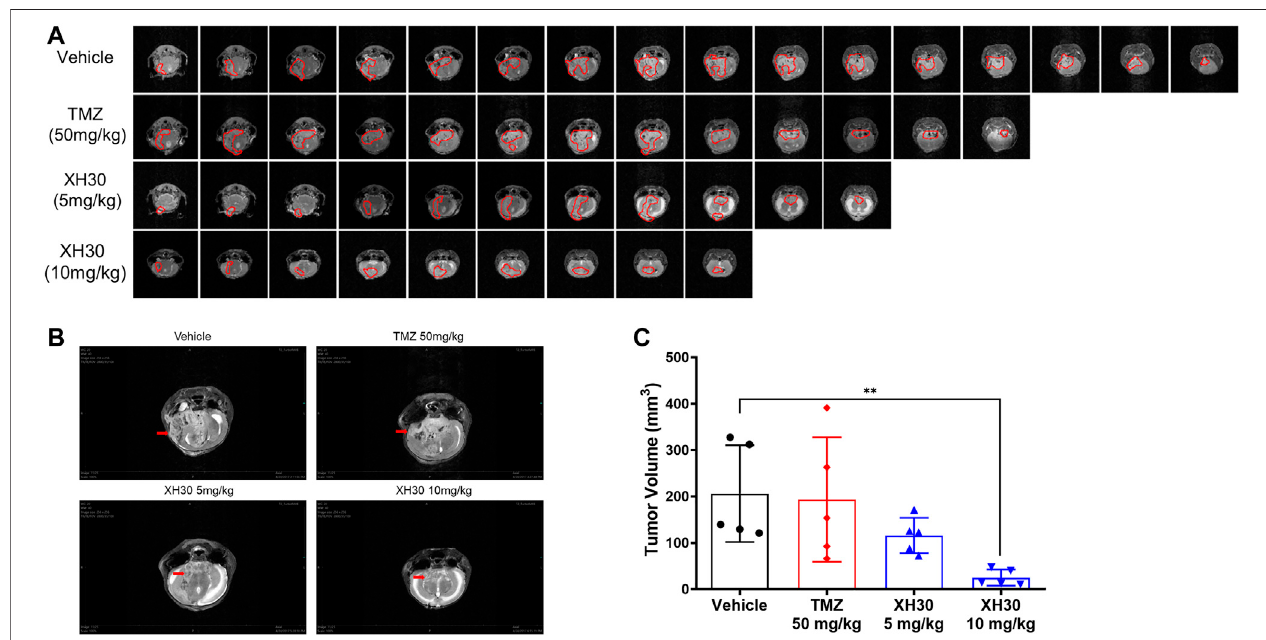
FIGURE 4 | XH30 repressed TMZ-resistant GBM growth in a mouse orthotopic xenograft model. (A) magnetic resonance imaging (MRI) T2-weighted image of intracranial tumors from the various groups from the U251/TMZ orthotopic model at day 9. Images in each lane show all tumor slices from one representative mouse in each group. The red curves indicate the tumors. (B) Representative MRI images from the U251/TMZ orthotopic model at day 9. The red arrows indicate the tumor. (C) Tumor volumes in the U251/TMZ orthotopic model at day 9. Data are presented as means ± SD, n (cid:1) 5. ANOVA, ** p < 0.01 compared with the vehicle control